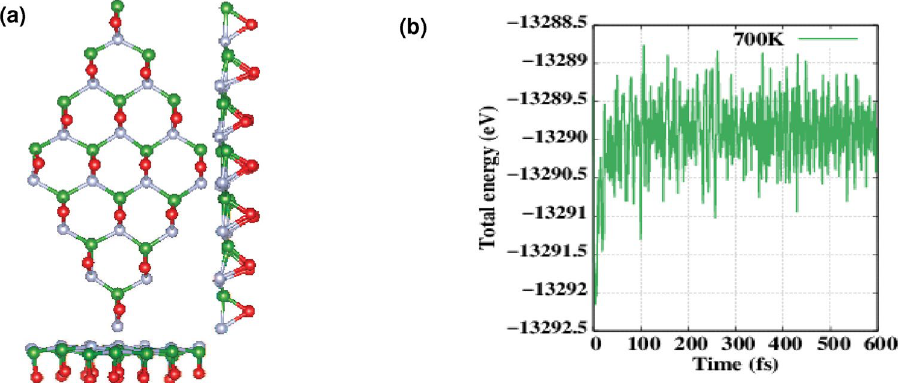
Figure 7. ( a ) Simulated structure of 2D functionalized hBN with (cid:31) = 4/8 after molecular dynamics annealing at 700 K for 600 fs. ( b ) Fluctuation of total energy ( 12 700